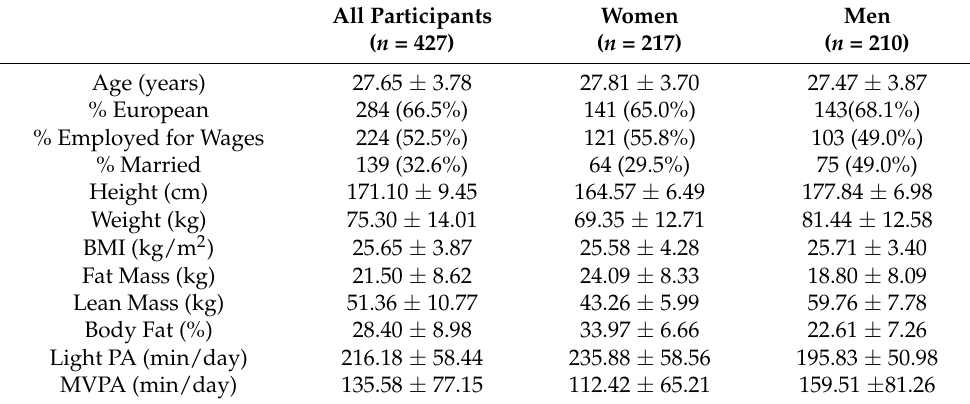
Table 1. Baseline characteristics of